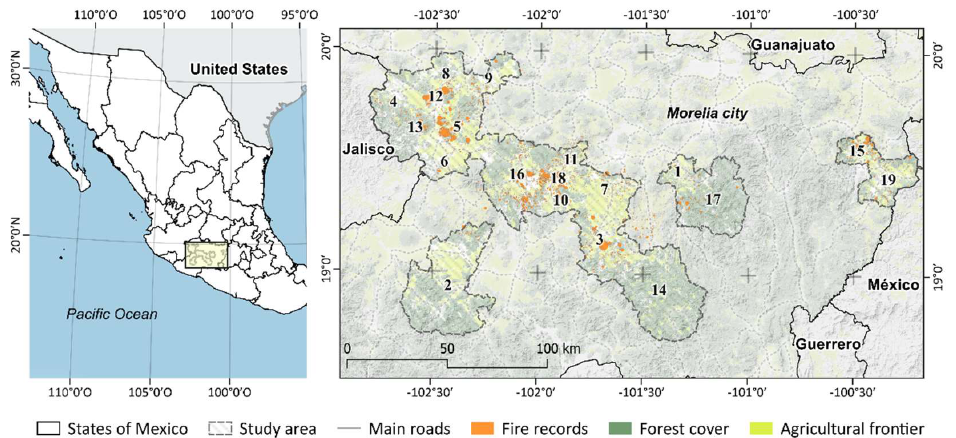
Figure 1. Region of study and fire records. The numbers correspond to municipalities in the following order. 1: Acuitzio, 2: Apatzingán, 3: Ario, 4: Cotija, 5: Los Reyes, 6: Peribán, 7: Salvador